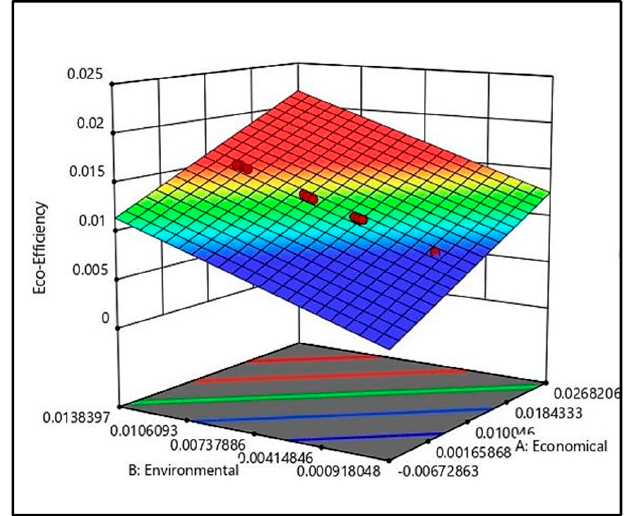
Figure 16. Response surface graph of blast furnace slag concrete used for single story houses.